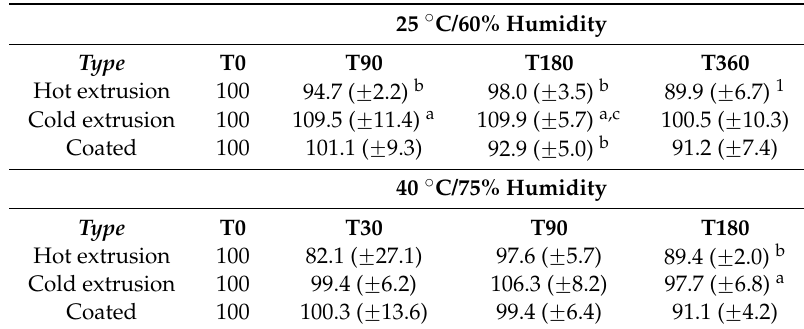
Table 3. Retention of iron over time, as percentage from iron concentration in uncooked fortified rice prior to storage